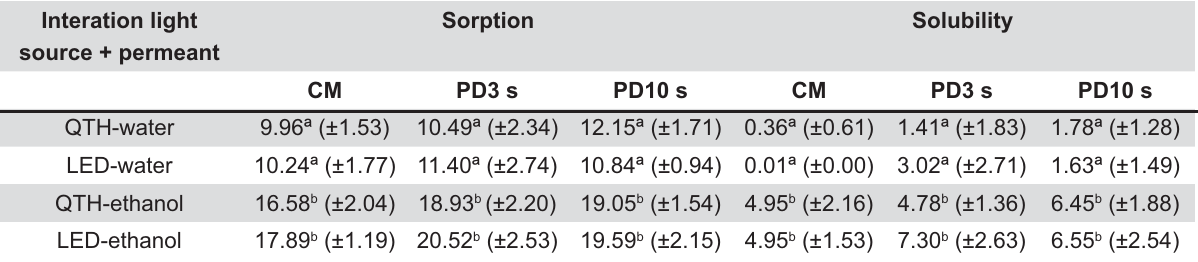
Table 2- Means, standard deviations (±SD) for comparison between light source and permeant for the measurement of sorption and solubility at 20 J/cm 2